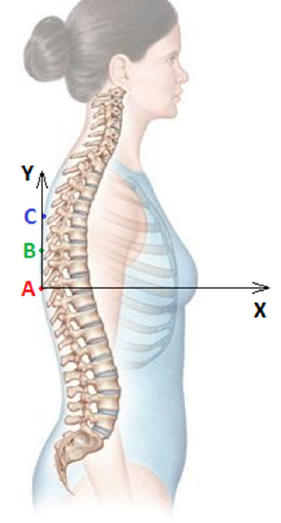
5 of 8 Figure 4. Sensor resistance vs. bending angle. Semilog plot ( y -axis has log scale). During all the experiments, the flex sensor was placed in the thoracic region of the